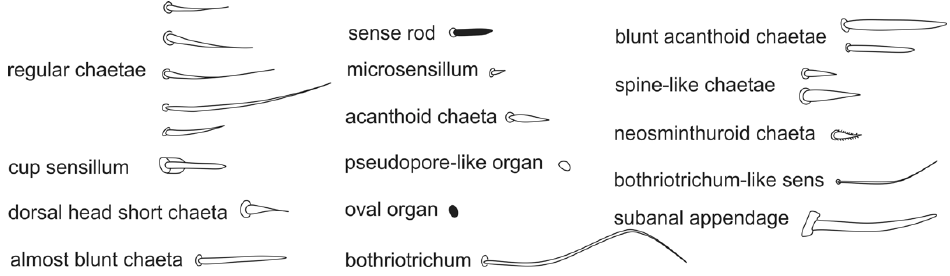
Figure 18. Chaetae symbols used in the chaetotaxy description of Calvatomina gladiata sp. nov. Diagnosis: Specimens mostly brownish, with a light sword image on dorso ‐ anterior